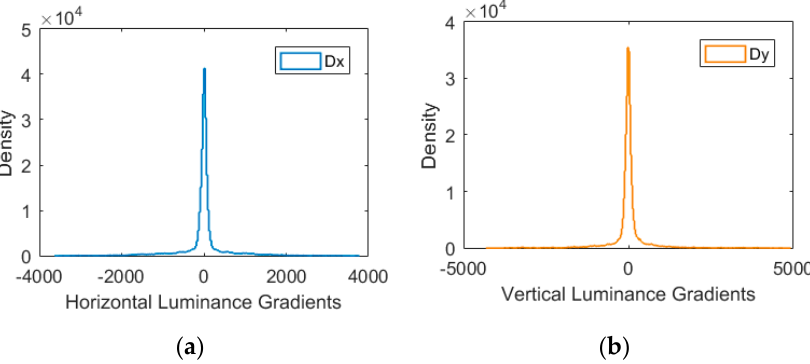
Figure 4. An example of gradient distributions for a natural image. ( a ) Dx represents the horizontal gradients (first derivative of the intensity function); ( b ) Dy represents the vertical gradients (first derivative of the intensity function).